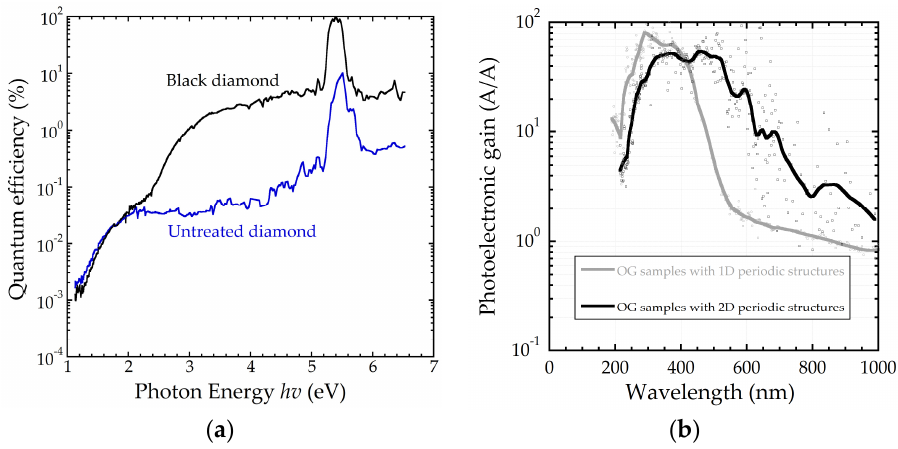
Figure 9. ( a ) Quantum efficiency as a function of radiation photon energy for a black diamond film and an untreated film [68] (CC BY 4.0). ( b ) Photoelectronic gain as a function of radiation wavelength for the optimally treated 1D ‐ periodic optical ‐ grade (OG, grey curve) and 2D ‐ periodic thermal grade (TG, black curve) samples. The photoelectronic gain represents the ratio between the quantum efficiency of the black diamond film and that of the pristine sample [83] (CC BY NC ND).